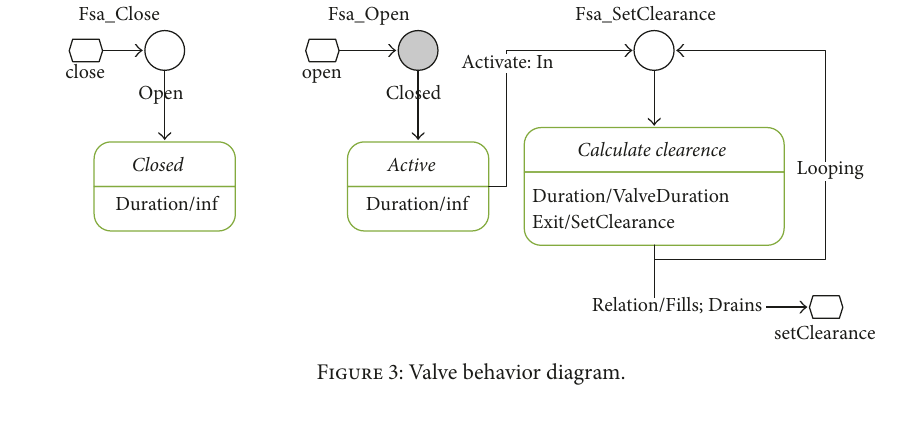
Figure 3: Valve behavior diagram.